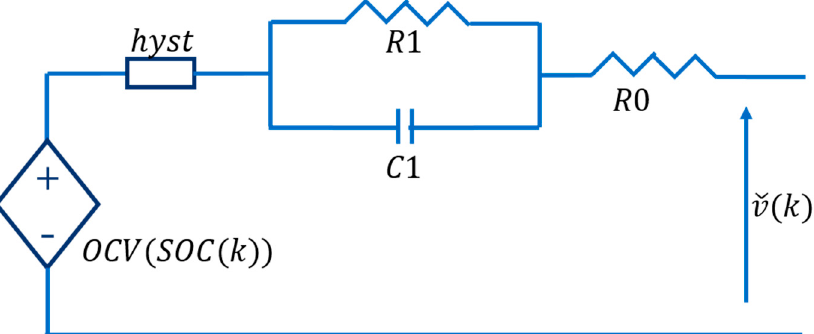
Figure 8 . Equivalent circuit that describes the dynamic model designed for terminal voltage and voltage loss prediction [37].